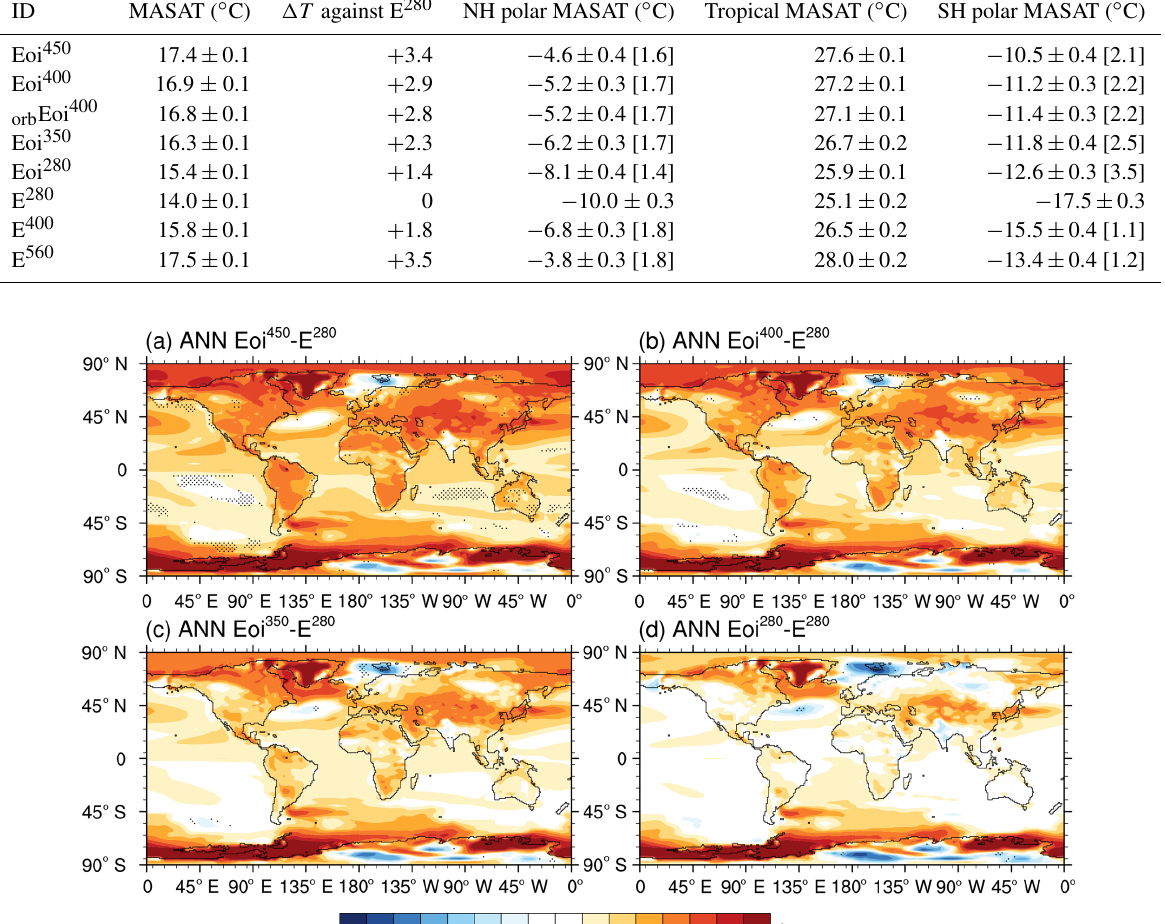
Table 3. Global mean annual surface air temperature (MASAT) and the mean annual surface air temperatures of the polar (poleward of 60 ◦ ) and tropical (equatorward of 30 ◦ ) regions. The polar amplification factor is shown in square brackets and is defined as the ratio in the anomalies (against E 280 ) between the polar warming and the global mean warming.